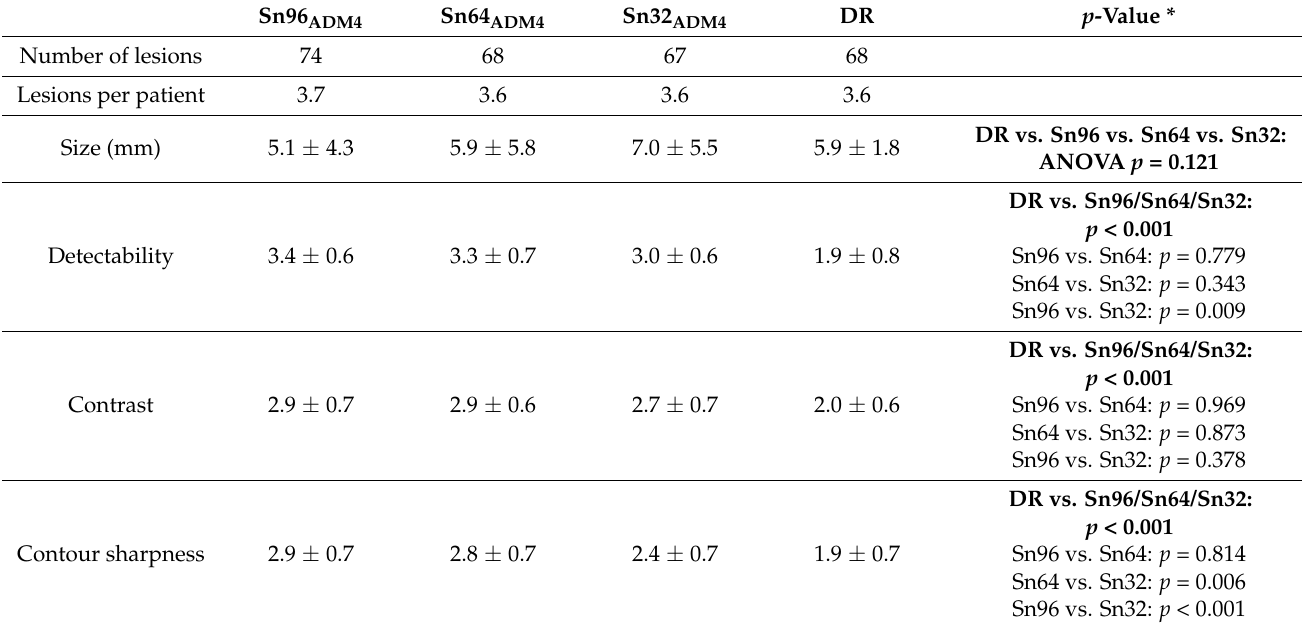
Table 3. Detectability, contrast and contour sharpness of lesions.